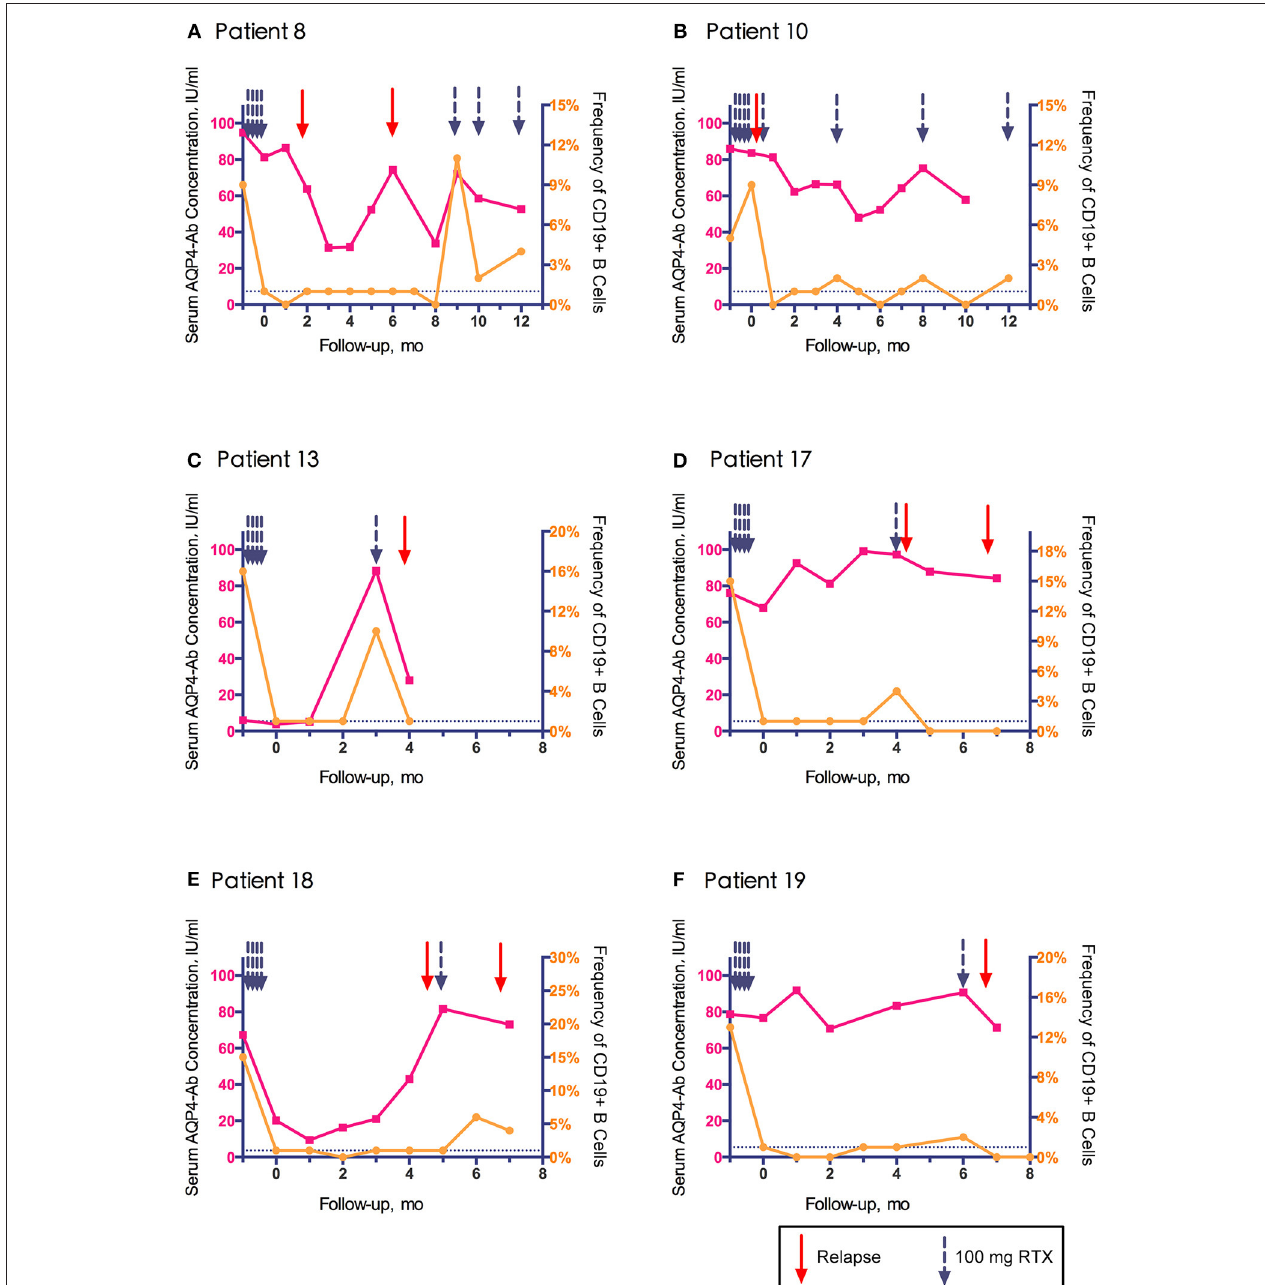
FIGURE 4 | Association of clinical relapse with CD19 + B cell frequency and aquaporin-4 antibody (AQP4-Ab) level in six relapsed patients with neuromyelitis optica-associated optic neuritis.